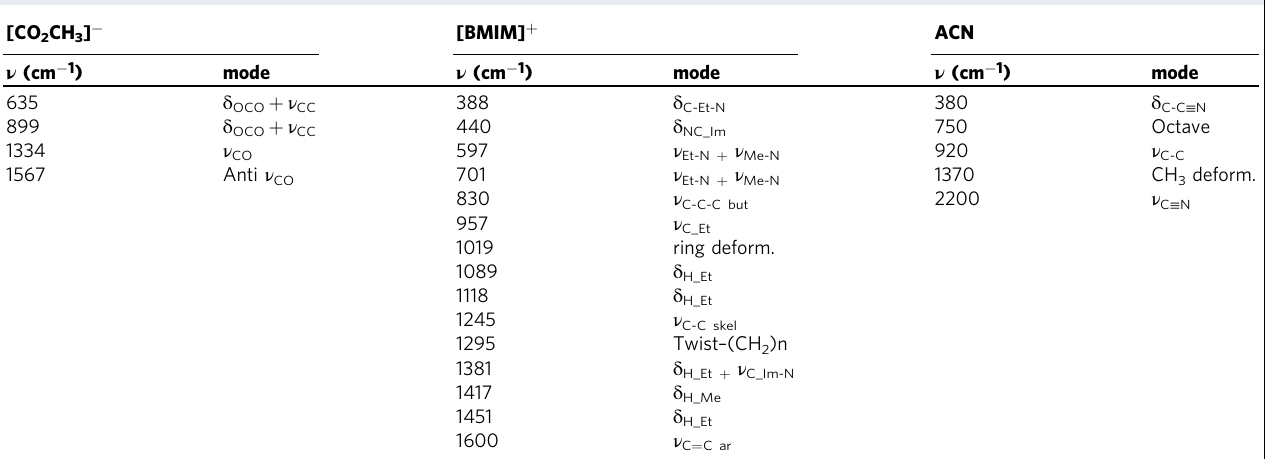
Table 2 Raman vibrational mode peaks attribution regarding spectra in Fig. 4 82